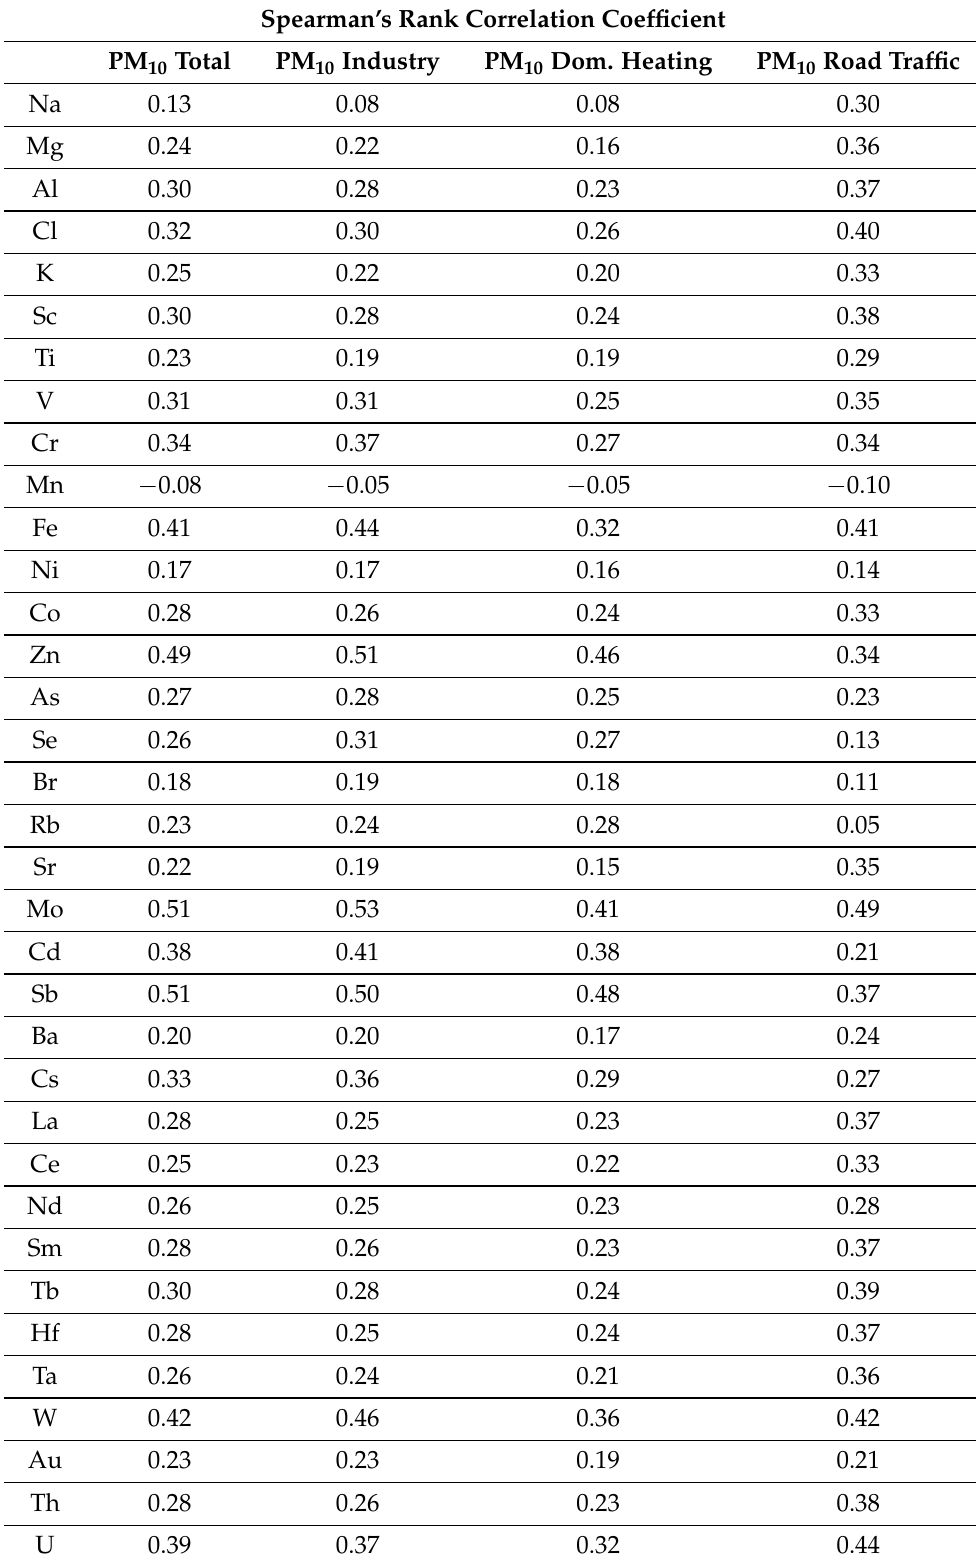
Table 5. Correlation between the INAA and ADMOSS